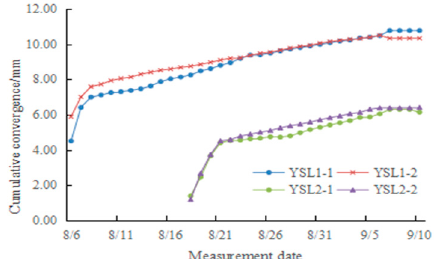
Figure 11. Relation between horizontal convergence and time.